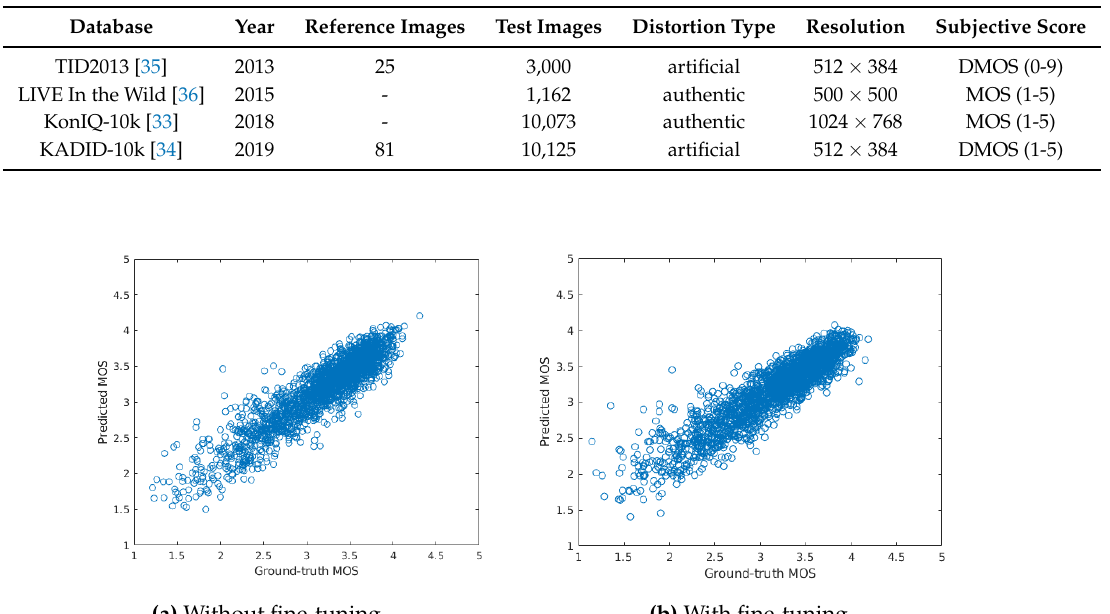
Table 6. Publicly available IQA databases used in this study. Publicly available IQA databases can be divided into two groups. The first one contains a smaller set of reference images and artificially distorted images are derived from them using different noise types at different intensity levels, while the second one contains images with "natural" degradation without any additional artificial distortions.